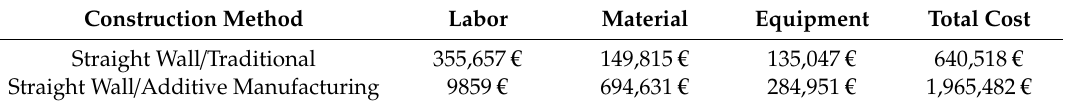
Table 3. Traditional manufacturing versus additive manufacturing: distribution of labour, material and equipment costs for concrete straight wall construction (Data Reproduced from